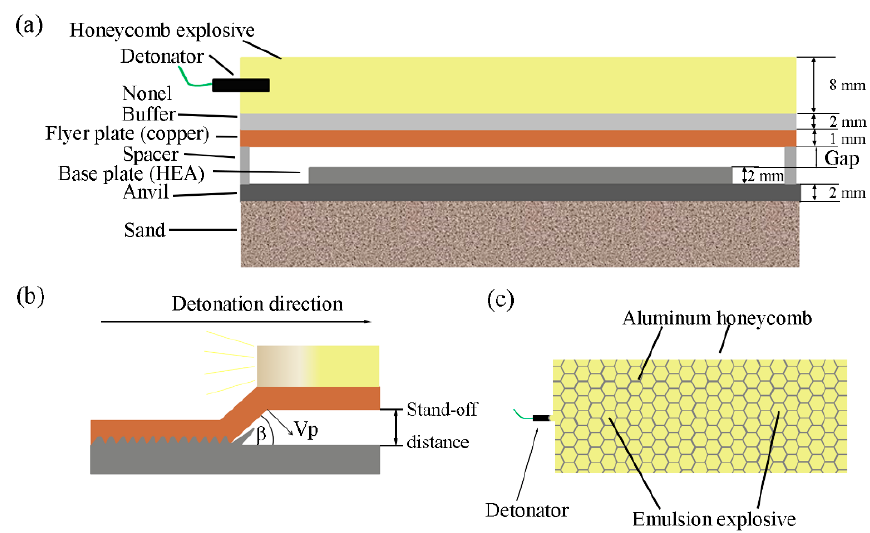
Figure 1. ( a ) EXW configuration using a honeycomb explosive, ( b ) Schematic diagram of the EXW process, ( c ) Schematic diagram of honeycomb explosive.